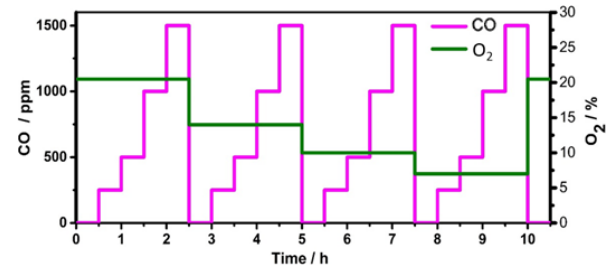
Figure 3. The gas exposure sequence over time for the sensitivity measurements of the CO/HC sensors. The sensors are exposed to 250, 500, 1000 and 1500ppm of CO at a 20.5, 14, 10.5 and 7% oxygen concentration. Figure 4. (a) The Varia 2R stove (Spartherm GmbH, Melle, Ger- many) used for the validation of the combustion process control. (b) The water-cooled SF10SK furnace (Brunner GmbH, Eggen- felden, Germany), and (c) the various types of CO/HC sensors in- stalled at the exhaust gas tube of the SF10SK fireplace. (d) The wood-stacking (e) upside-down combustion